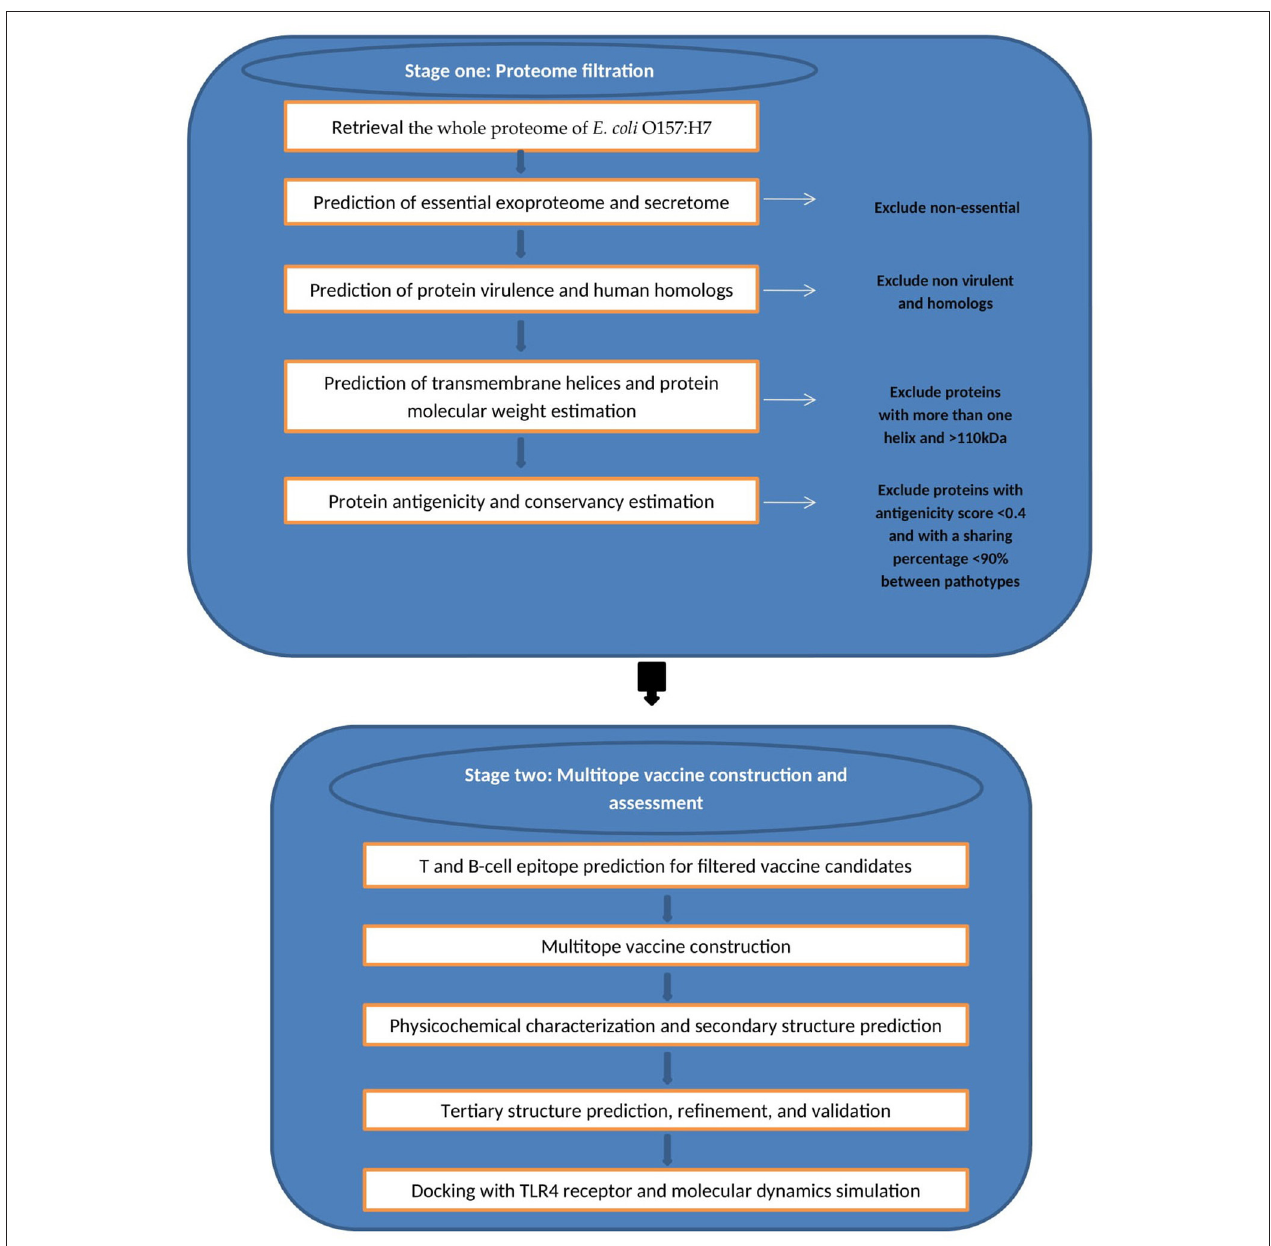
FIGURE 1 | Graphical representation of the methodology employed for the multi-epitope vaccine design against E. coli